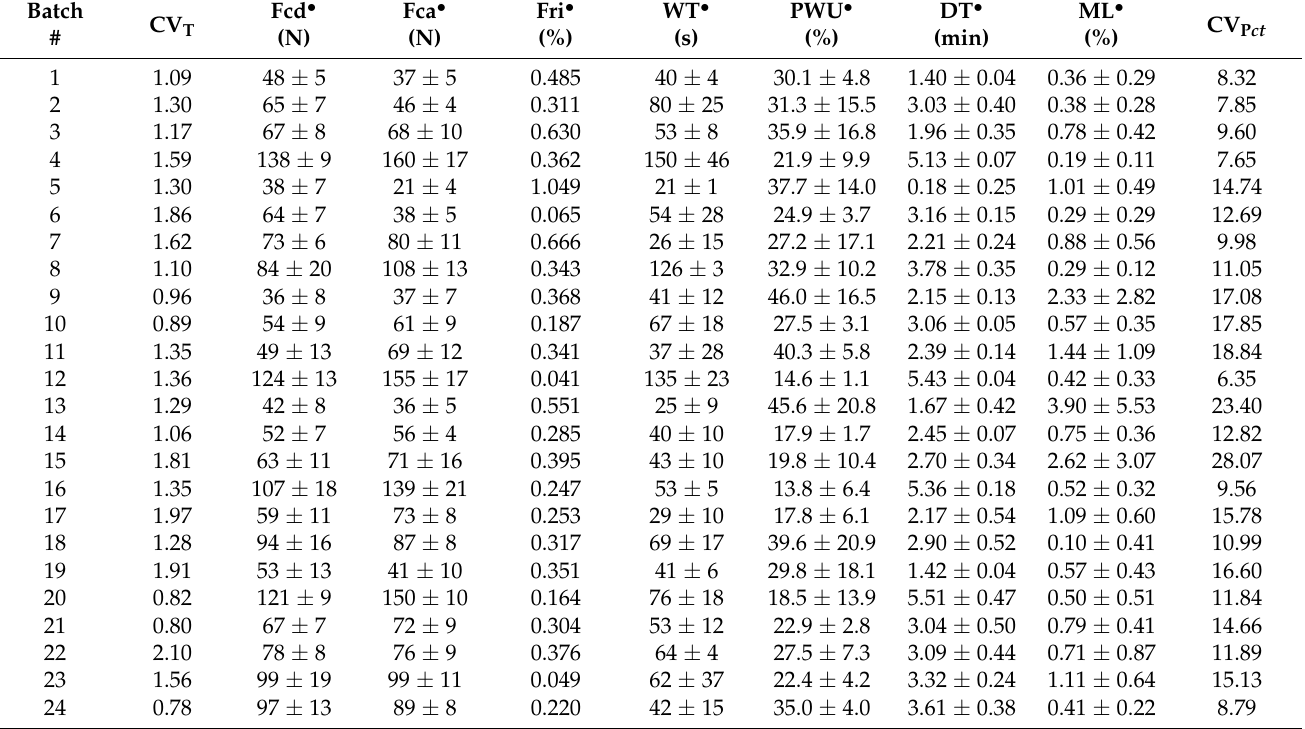
Table 4. Characteristics of ODTs manufactured according to FCCCD. CV T , coefficient of variation of tablet mass; Fcd, diametral crushing strength; Fca, axial crushing strength; Fri, tablet friability; WT, wetting time; PWU, percentage water uptake; DT, tablet disintegration time; ML ct , mass loss following splitting into four portions; CV P ct , coefficient of variation of portion